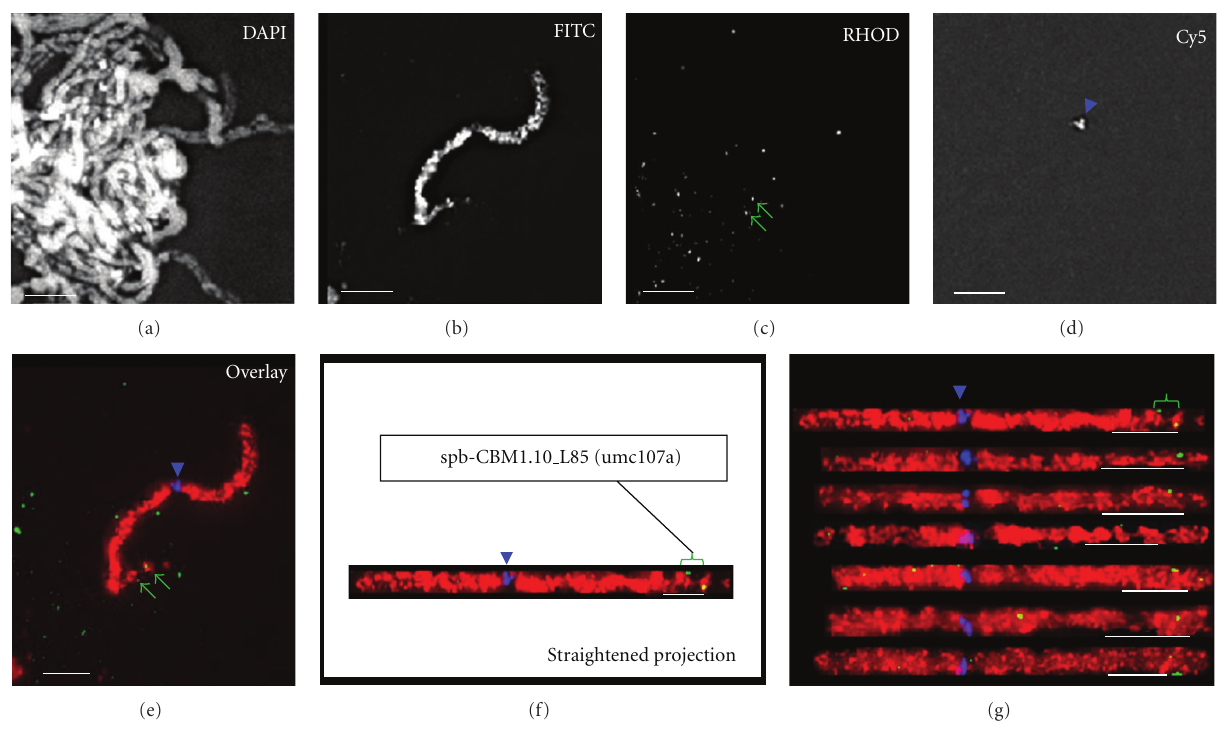
Figure 4: FISH mapping of maize CBM1.10 with sorghum BAC a0053G04. (a) A DAPI-stained image of spread pachytene chromosomes fromOMAd1.36. (b) FITC imageshowingmaize chromosome1 direct-labeled withAlexa-488-dUTP-KWF total maizeDNA. (c) Rhodamine image from direct-labeled sorghum BAC FISH signals (green arrows). (d) Cy-5 image of centromere FISH signal (blue arrowhead) with direct-labeled CentC. (e–g) Three-color overlay of the FITC (red), rhodamine (green), and Cy-5 (blue) images. (f) Straightened projection of the maize chromosome from panel (e). The locations of the centromere (blue arrowhead) and CBM1.10 BAC FISH signals(green bracket) are indicated along with the resulting cytogenetic locus name (boxed). (g) Straightened projections of six additional chromosomes aligned at their centromeres for comparison. All scale bars represent 5 μ